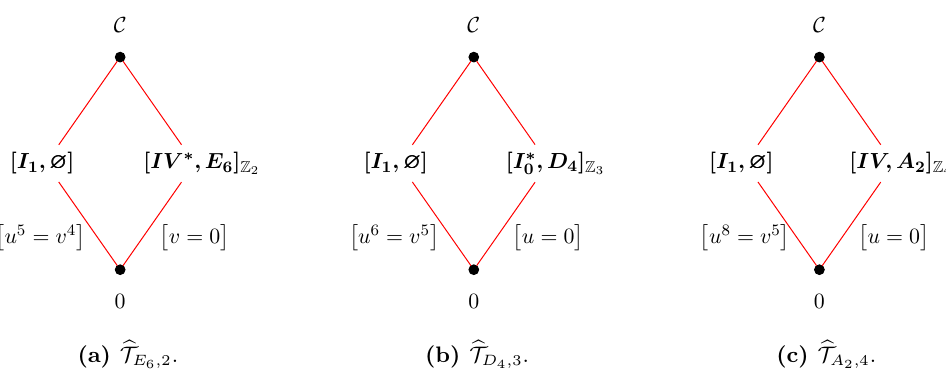
Figure 11. Special K(cid:127)ahler strati(cid:12)cation of the N = 2 SCFTs obtained by turning on the masses corresponding to the SU(2) (cid:13)avor factors of (a) T (2)